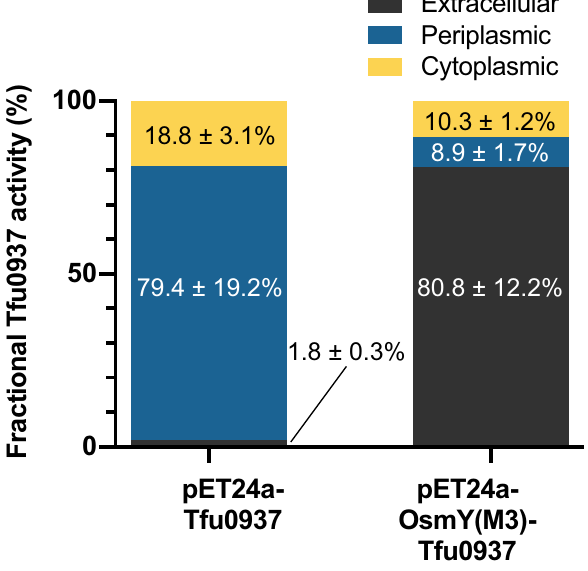
Figure 5. Subcellular localization of Tfu0937 and OsmY(M3)-Tfu0937. Proteins were expressed using pET24a-Tfu0937 and pET24a-OsmY(M3)-Tfu0937 in 2 × TY auto-induction medium at 37 °C for 15 h. The fractional Tfu0937 and OsmY(M3)-Tfu0937 activity in the extracellular, periplasmic and cytoplasmic fractions were measured with the pNPG assay using an absorbance at 405 nm. The enzyme activity in each